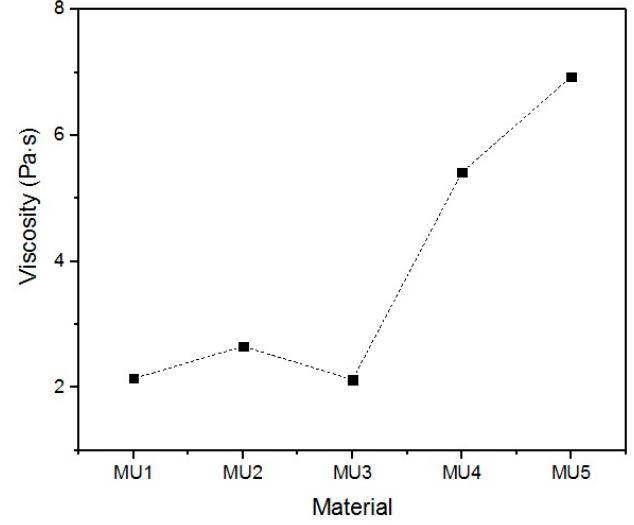
Figure 19. Influence of filler content on average prepolymer viscosity at CSR = 100 s − 1 .